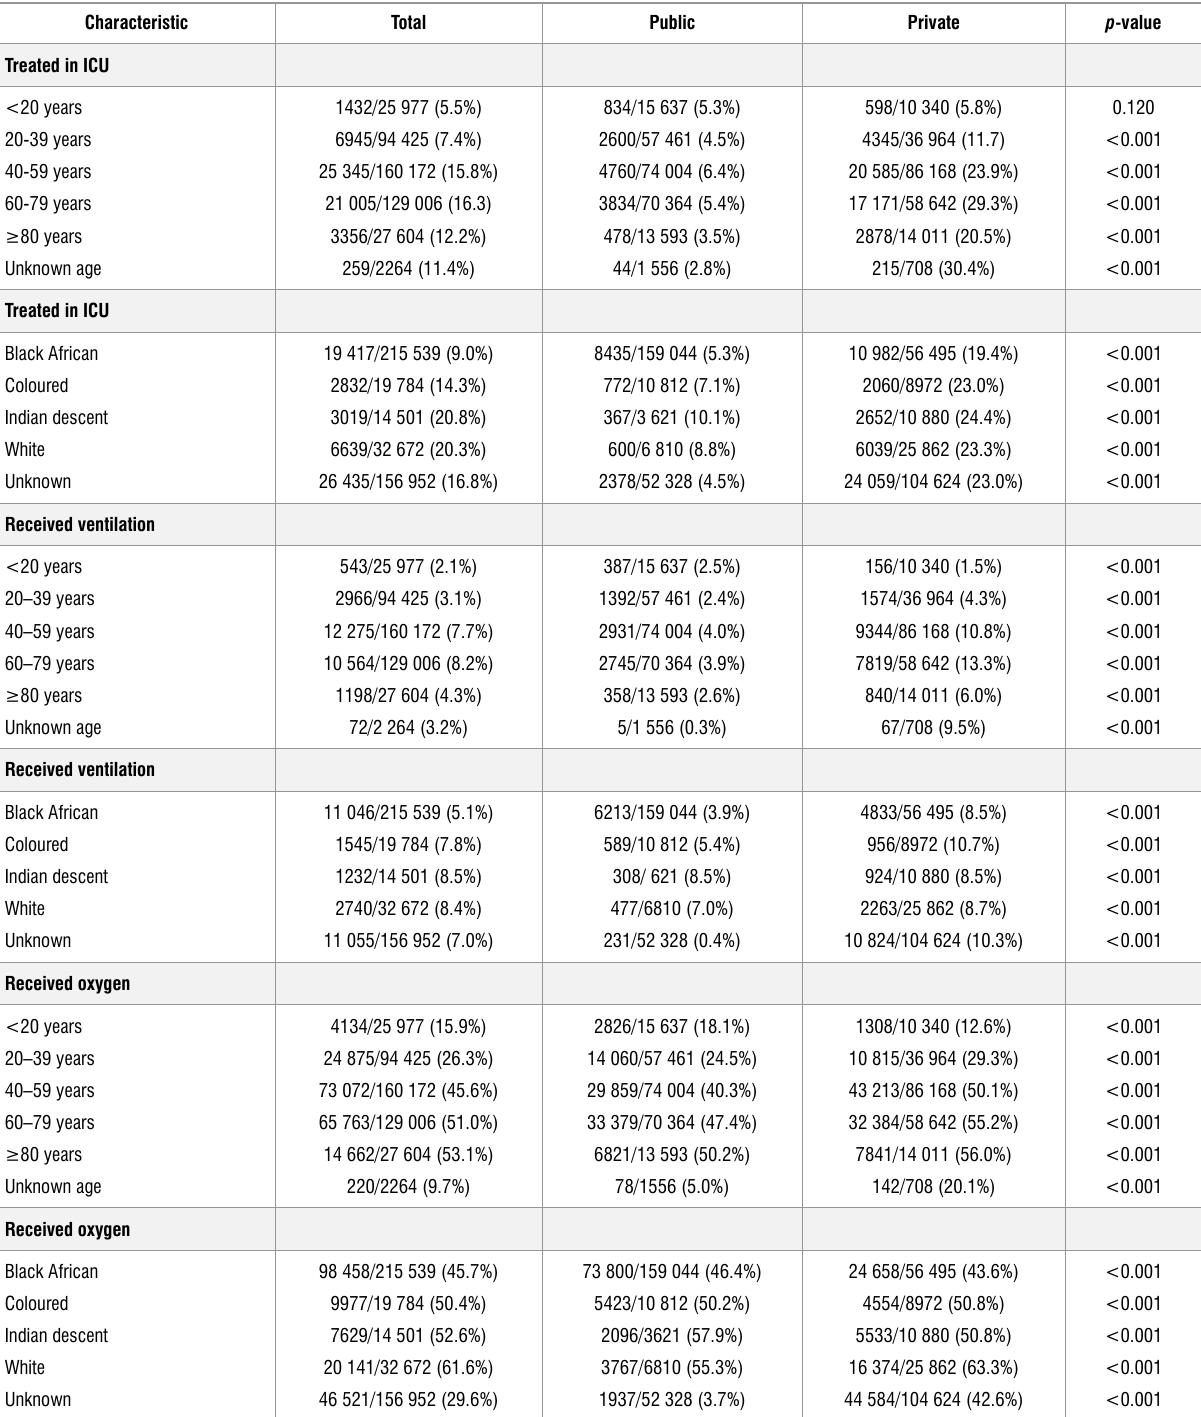
Table 6: Description of settings of care for in-hospital COVID-19 patients by health sector, age and race group, South Africa, 5 March 2020 to 8 January 2022 ( N =439 448) Characteristic